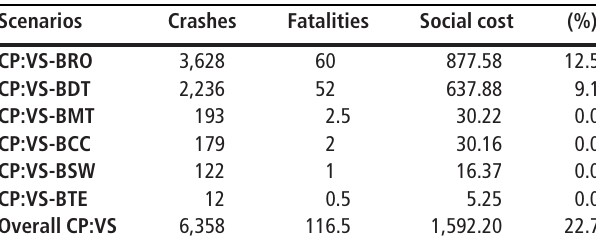
Table V Crashes, fatalities and social cost of CP:VS